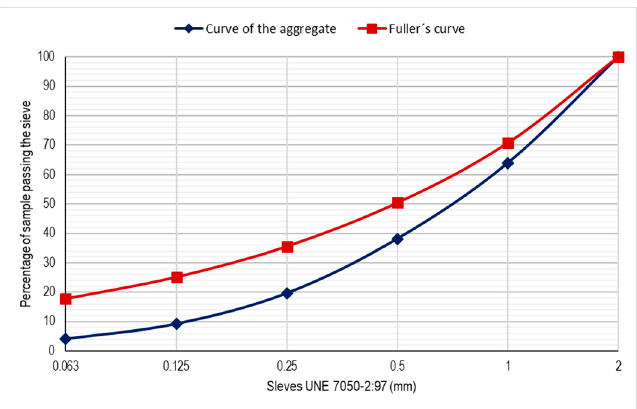
Figure 1. Aggregate particle size of crushed glass. Reprinted from Flores ‐ Alés, V., Alducin ‐ Ochoa, J. M., Martín ‐ del ‐ Río, J. J., Torres ‐ González, M., and Jiménez ‐ Bayarri, V. (2020). Physical ‐ mechanical behaviour and transformations at high temperature in a cement mortar with waste glass as